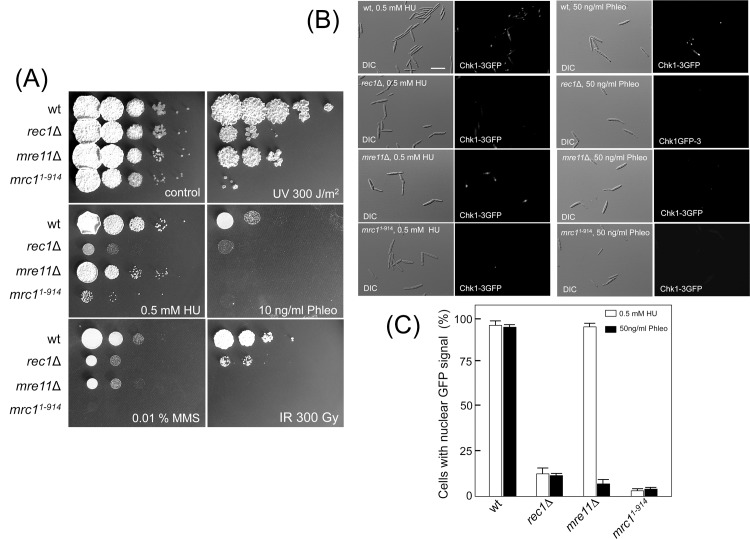
DNA damage response is dependent of Rec1, Mre11 and Mrc1
proteins.(A) Sensitivity of the rec1Δ,
mre11Δ and
mrc1
1-914 cells,
subject to different types of genotoxic stress (HU, hydroxyurea; MMS,
methyl methanesulfonate; Phleo, phleomycin; IR, ionizing radiation).
10-fold dilutions were plated onto YPD medium containing the indicated
drug or irradiated with UV light or IR after being plated onto YPD
medium. Control plate was incubated for 2 days while treated plates were
incubated for 3 days. (B) Nuclear localization of Chk1-GFP after the
induction of genotoxic stress (hydroxyurea, HU, and, Phleomycin, Phleo)
in the rec1Δ, mre11Δ and
mrc1
1-914 mutant
strains. Bar: 15 μm. (C) Quantification of cells showing nuclear
GFP signal. The graph shows the result from two independent experiments,
counting more than 50 cells each. Means and SDs are shown.